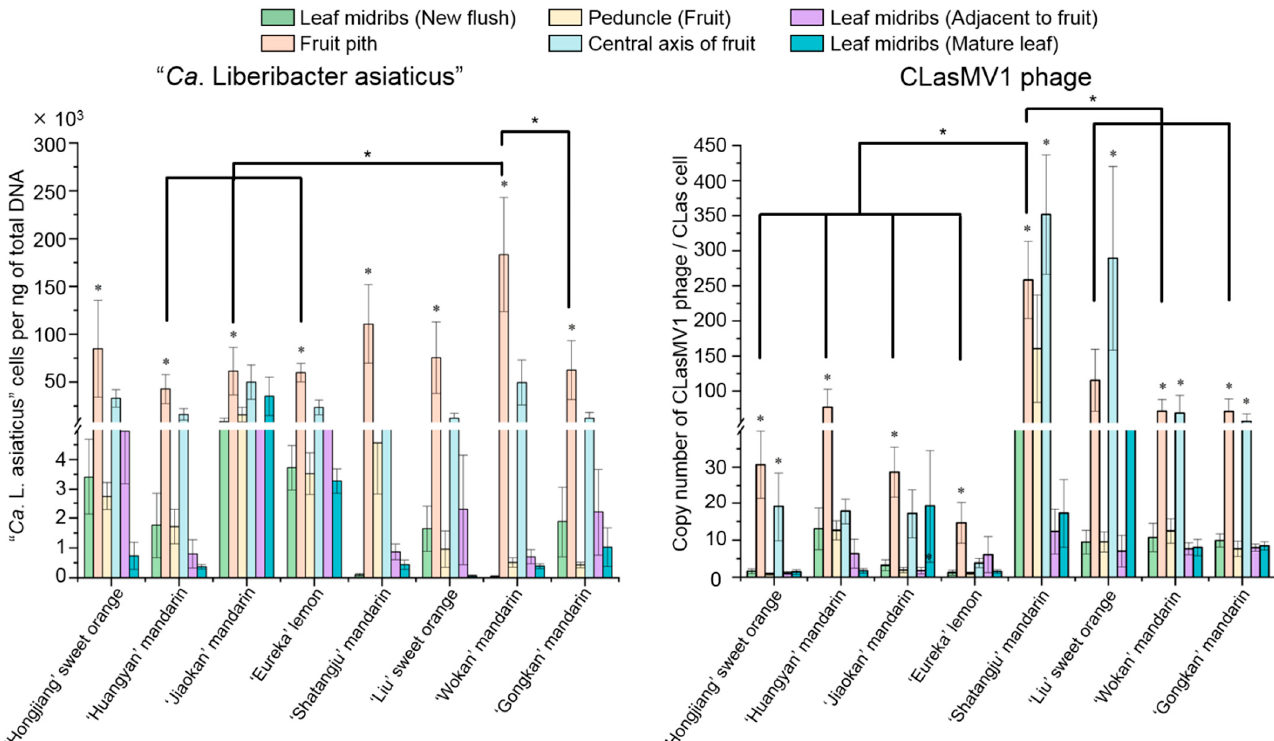
Figure 2. Quantification analyses of “ Candidatus Liberibacter asiaticus” and CLasMV1 phage in six types of tissues from citrus branch. Single factor ANOVA (Duncan’s multiple range test) at 95% ( p < 0.05) confidence interval is used to determine statistical significance. *: p < 0.05.